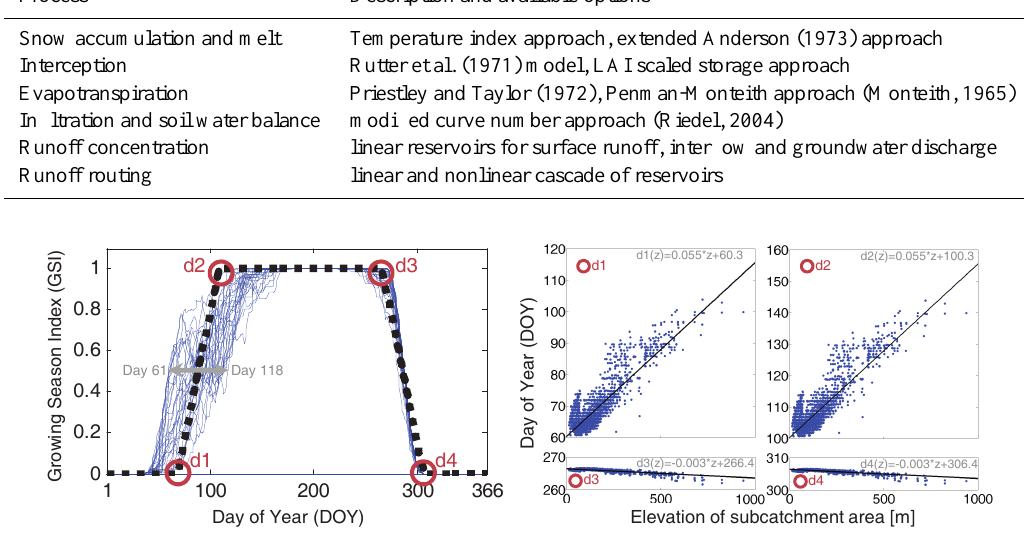
Fig. 3. Beginning of spring as observed (blue) and calculated (red) for three different sites in Lower Saxony.